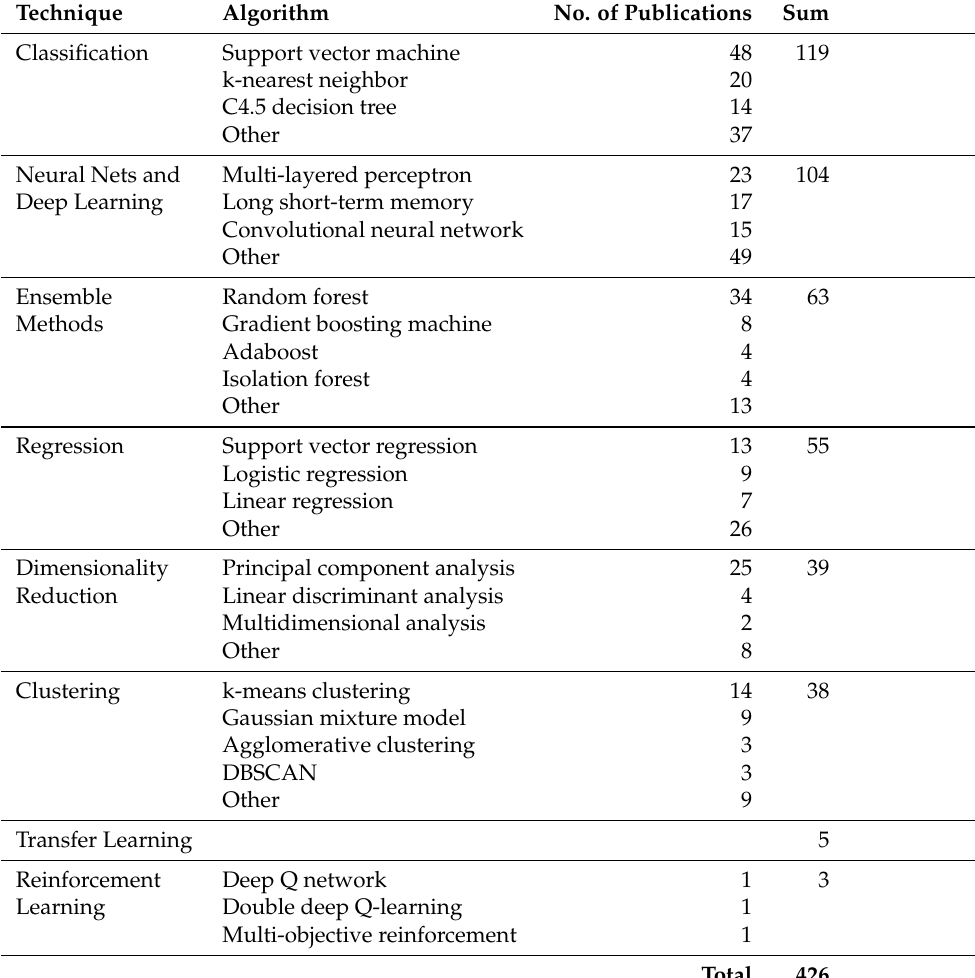
Table 4. Techniques and top three